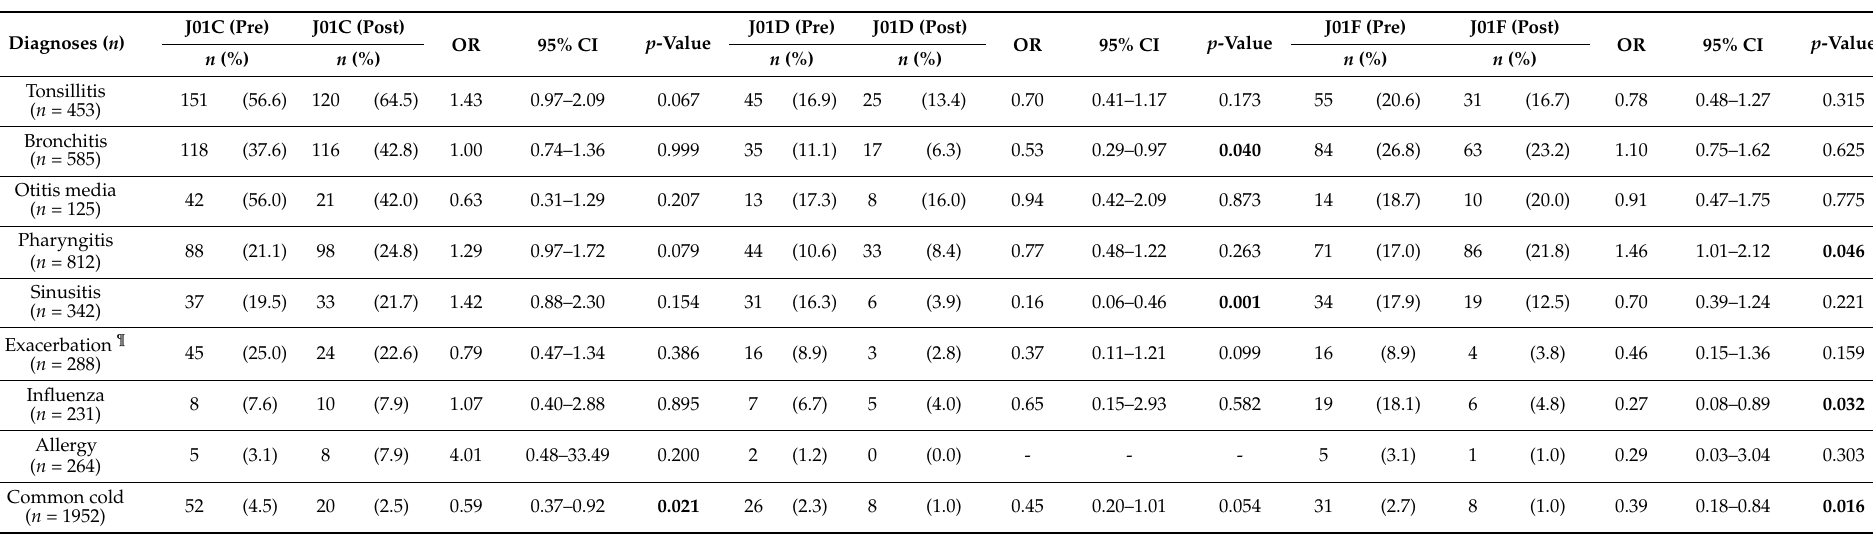
Table 5. Diagnosis-specific antibiotic prescribing for the three most commonly prescribed antibiotic classes, pre- and post-intervention ( n = 5296 eligible aRTC